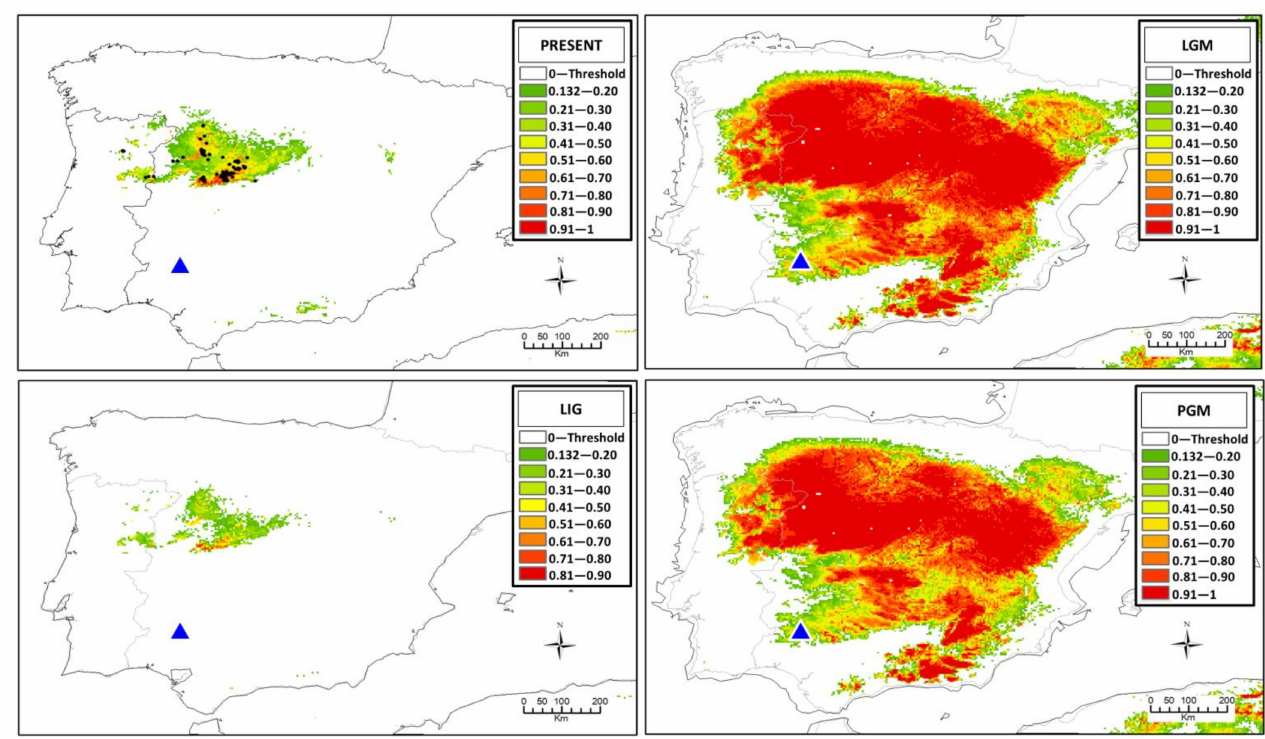
Figure 6. Potential distribution of Centaurea amblensis at present, Last Glacial Maximum (LGM), Last Interglacial Period (LIG), and Penultimate Glacial Maximum (PGM) conditions. Shaded areas indicate the probability of presence according to the scale of color shown in the figure. Black dots represent the locations used to construct the model. The solid black line indicates the coastline of the Iberian Peninsula at the two glacial maxima (LGM and PGM). The blue triangle represents the actual population of Centaurea tentudaica